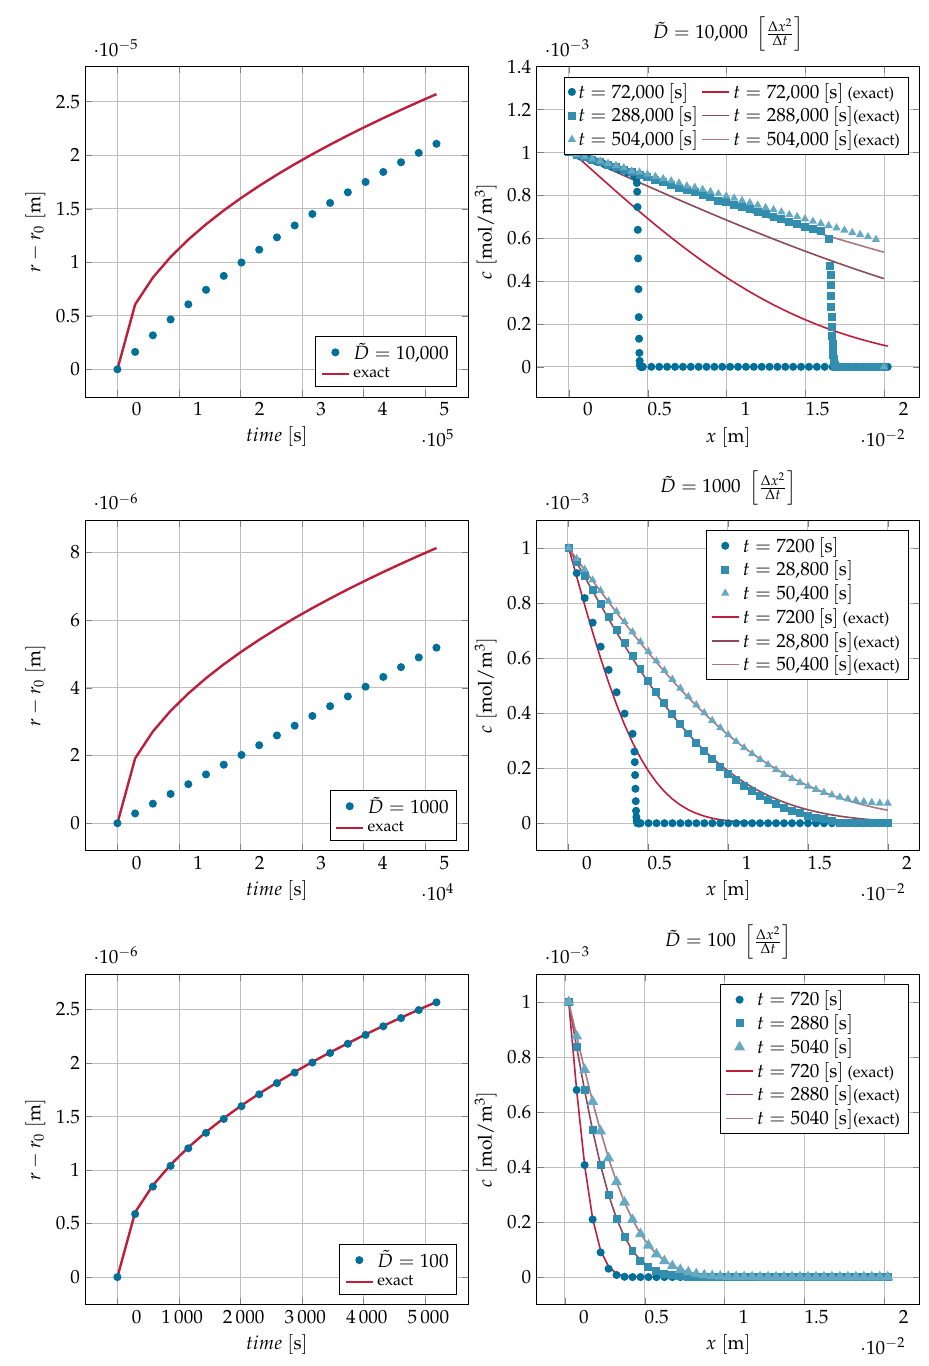
Figure 5. The interface displacement predicted numerically for the channel with diffusion-controlled dissolution using three different values for ˜ D displacement calculated from Equation (27) (left column). The concentration profiles corresponding for different diffusivities ˜ D compared with the exact profiles for different times are shown in the right